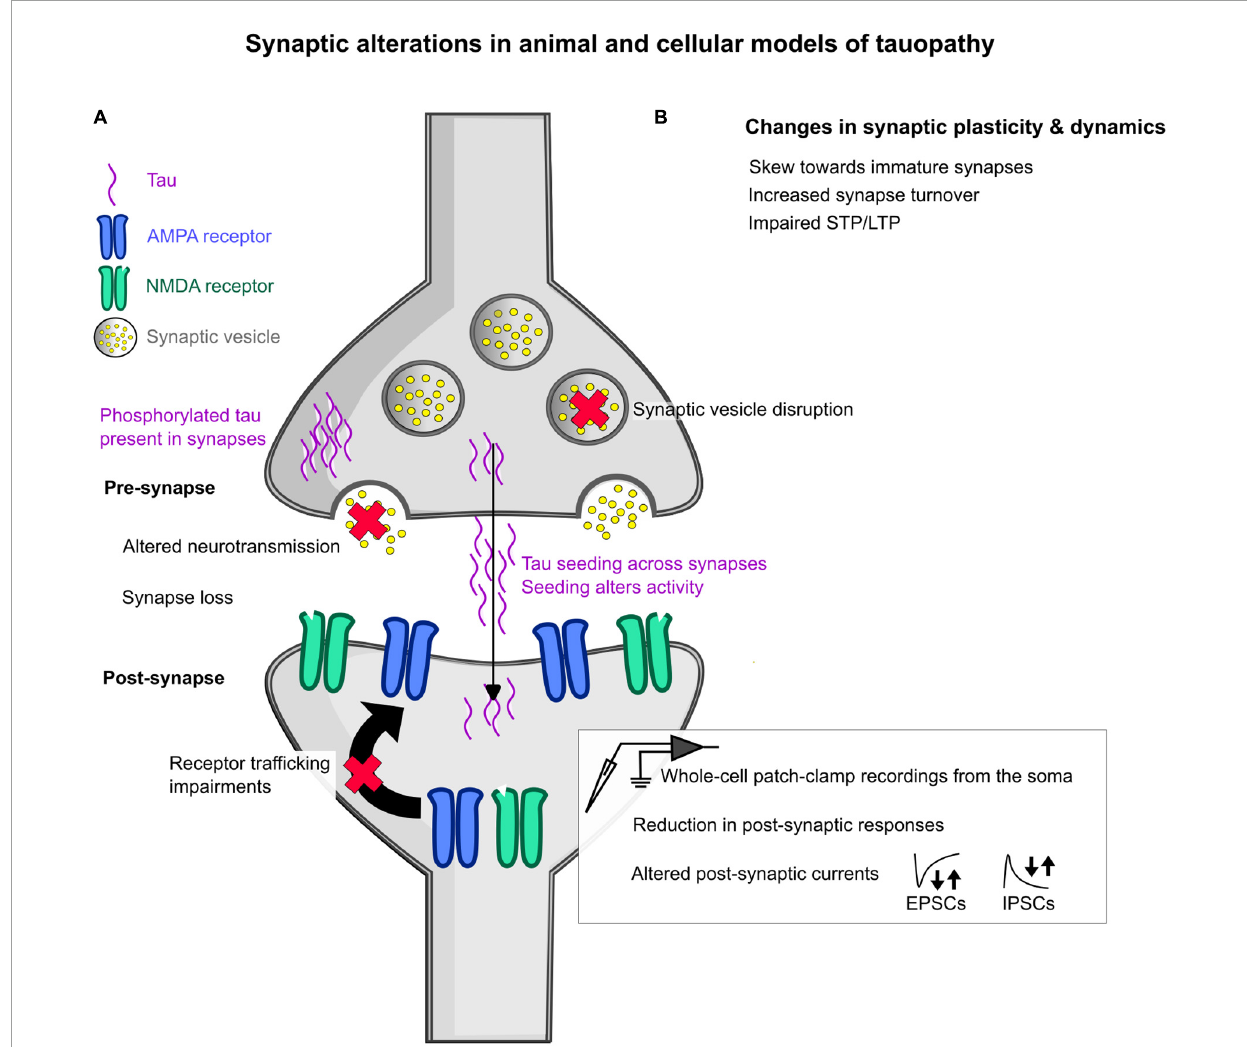
FIGURE2 Schematic overview of some of the changes induced by tauopathy in animal and cellular models at the synapse. (A) General changes in synaptic function at the pre- and post- synapse in animal models of tauopathy. In the pre-synapse, synaptic vesicle disruption has been observed, as denoted by a red cross over the synaptic vesicle. Altered neurotransmission has also been seen, denoted by a red cross over the neurotransmitters shown as yellow dots. The detection of mislocalized phosphorylated tau has been seen at both the pre- and post-synapse, highlighted as purple waves in each synaptic space. Tau is also thought to seed across synapses by multiple hypothesized mechanisms, with this seeding shown to alter activity in the brain. At the post-synapse, glutamatergic receptor trafficking is impaired showing a loss of receptors at the post-synaptic domain. In addition, measures using whole-cell patch-clamp electrophysiological recordings revealed reductions in post-synaptic responses to stimulation and increased or decreased frequency of spontaneous and miniature excitatory post-synaptic currents (EPSCs) and inhibitory post-synaptic currents (IPSCs), denoted by the arrows. (B) Changes that have been observed in synapse plasticity and dynamics include a skew in synapse shape toward “immature” synapses, increased synapse turnover, and impairments in short-term and long-term plasticity (STP and LTP,